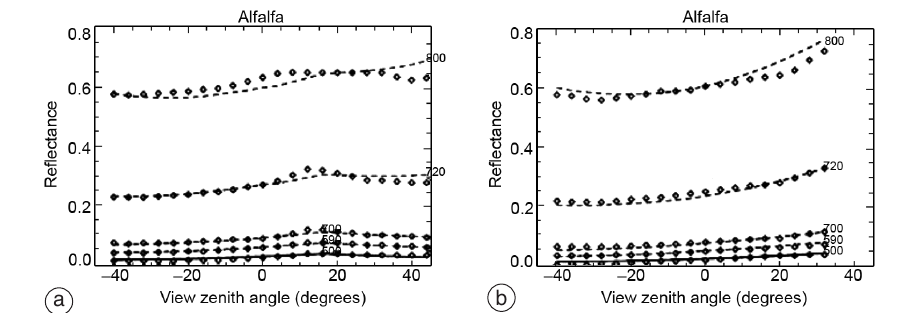
Fig. 2a,b. Comparison of directional signatures in the principal plane measured by POLDER (symbols) and si- mulated by DISMA (dashed line) at five different bands for alfalfa. a) Noon image ( i V = 17°); b) 14:30 UTC ( i V =